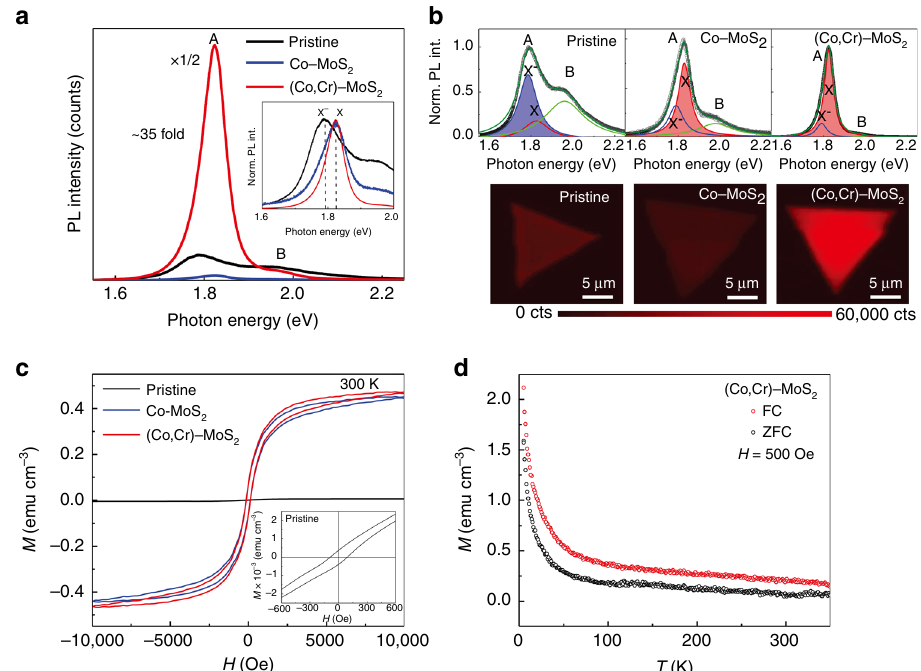
Fig. 3 Characterization of luminescent and magnetic properties. a Unnormalized PL spectra of pristine monolayer MoS 2 , Co – MoS 2 , and (Co, Cr)-MoS 2 . The inset shows the normalized PL spectra. b Analysis of the PL spectral shapes and PL intensity mappings, and c Magnetization vs magnetic fi eld ( M-H ) curves. d Temperature-dependence of magnetization ( M – T ) curves of (Co,Cr)-MoS 2 with FC and ZFC